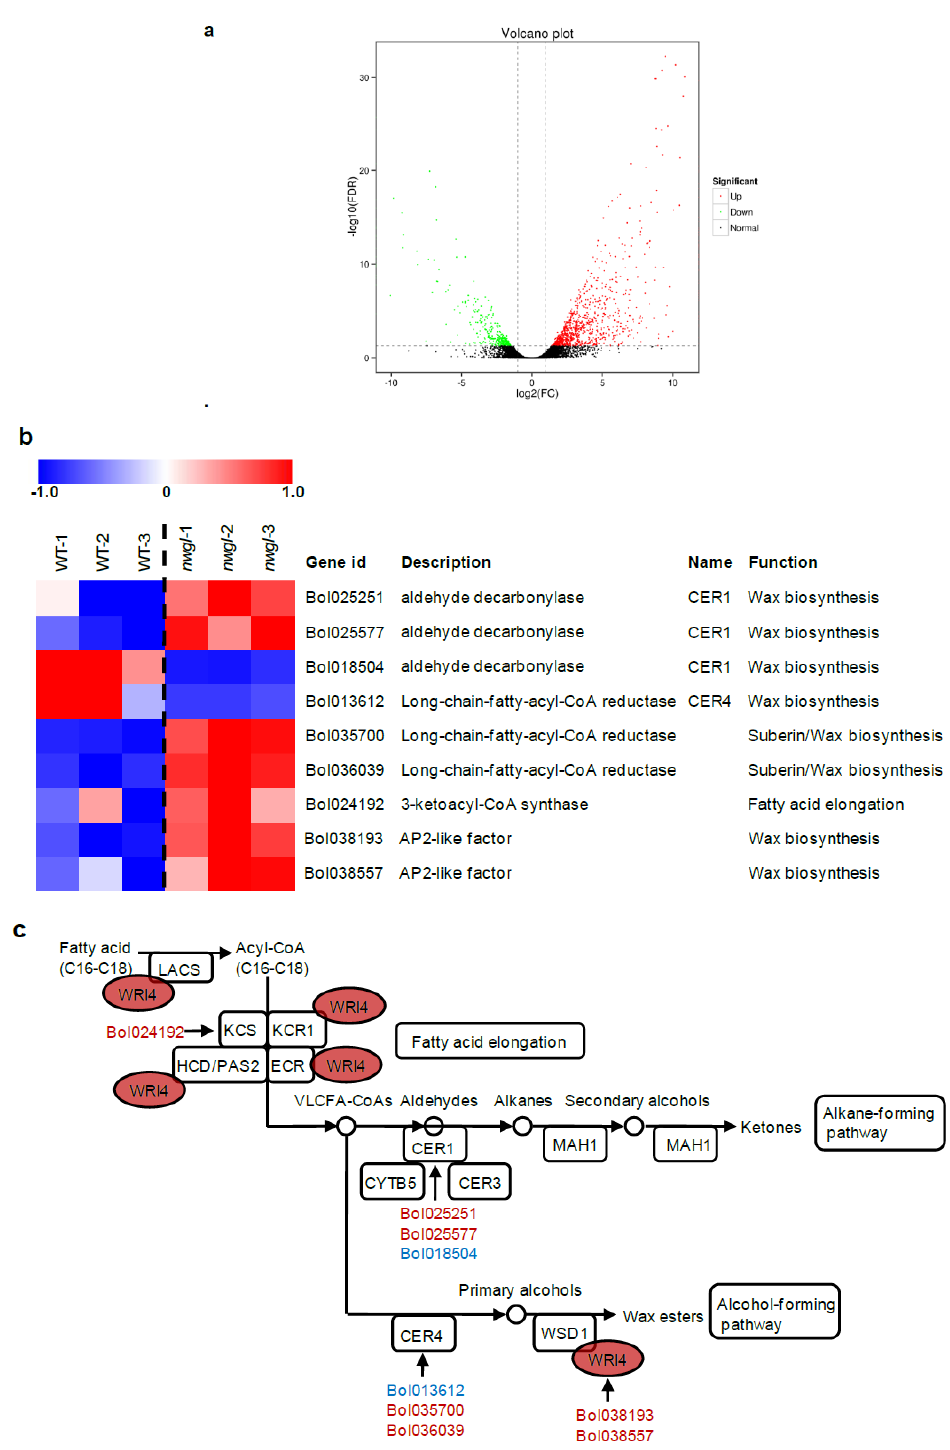
Figure 4. Analysis of DEGs in the RNA-seq libraries. ( a ) Volcano plot showing significant DEGs. Red and green dots represent up and down-regulated DEGs, respectively (FDR < 0.05). Black dots are genes that were not di ff erently expressed. ( b ) Gene expression of DEGs involved in wax biosynthesis. The data are shown in base 2 logarithmic form (log2 FPKM). Three biological replicates of wild-type (WT) and nwgl leaves are exhibited. ( c ) Simplified pathways for wax biosynthesis. LACS, long chain acyl-CoA synthetase; KCS, β -ketoacyl-CoA synthase; KCR, β -ketoacyl-CoA reductase; HCD / PAS2, β -hydroxyacyl-CoA dehydratase; ECR, enoyl-CoA reductase; CER, ECERIFERUM; CYTB5, cytochrome b5 isoform; MAH, mid-chain alkane hydroxylase; WSD, wax synthase / diacylglycerol acyltransferase; WRI4, WRINKLED4. Down-regulated and up-regulated genes in nwgl vs. wild-type plants are marked in green and red color,